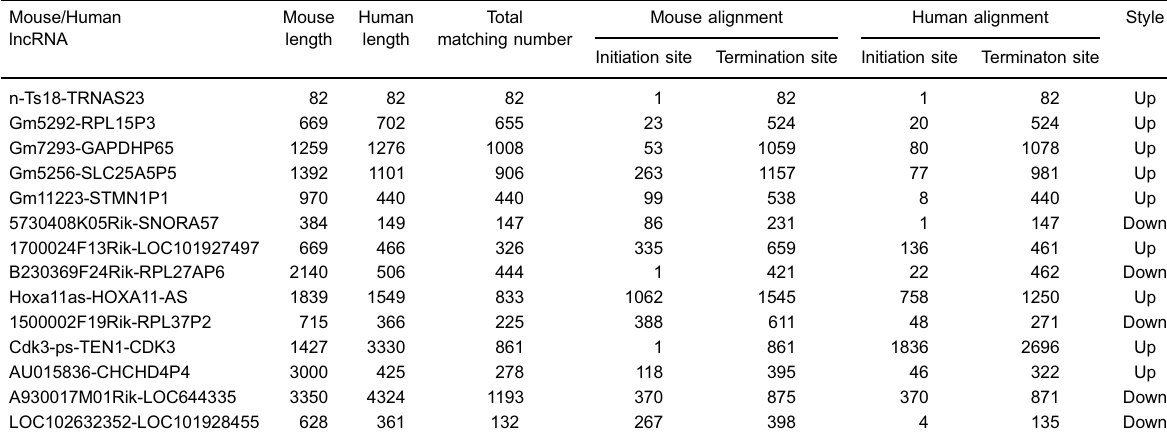
Figure 3. lncRNA CHCHD4P4 is upregulated in the HK-2 cells that were exposed to calcium oxalate monohydrate. A , Application of the BLAST algorithm in mouse and human lncRNAs identi- fi ed 15 pairs of homologous lncRNAs (Table 2). B , Validation of the differential expression of CHCHD4P4 and AU015836 in the CaOx models and control groups using RT-PCR. C , Nuclear and cytoplasmic CHCHD4P4 RNAs from the HK-2 cells. Data are reported a means ± SD. *P o 0.05, **P o 0.01 ( t -test).